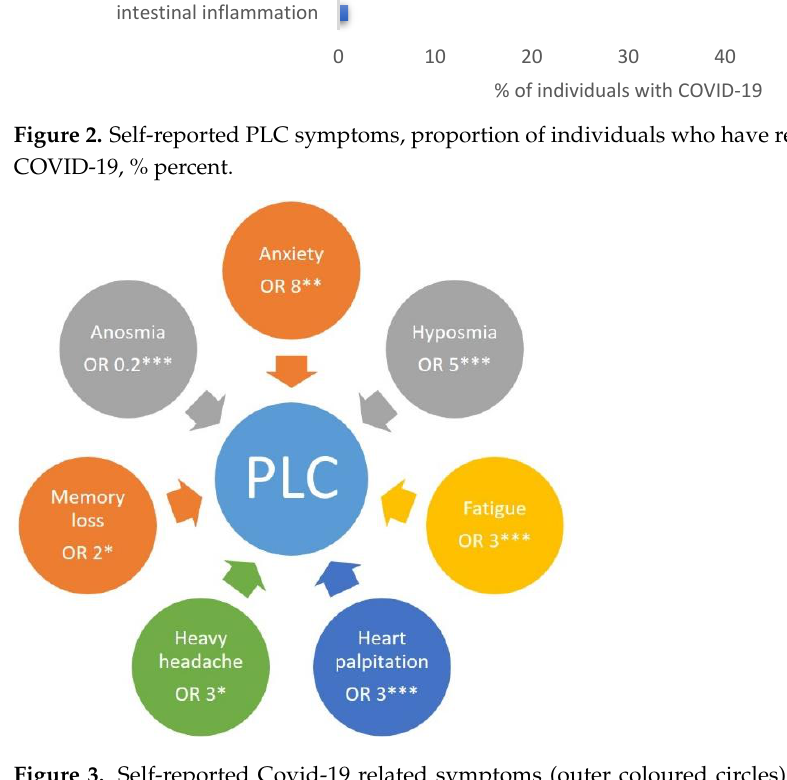
Figure 3. Self-reported Covid-19 related symptoms (outer coloured circles) with a relevant and significant probability for the development of PLC (inner blue circle) according to the results from adjusted multivariable logistic regression analysis. The number in the outer circles represents the probability (OR) of developing PLC, the stars represent the statistical significance. OR, odds ratio. *